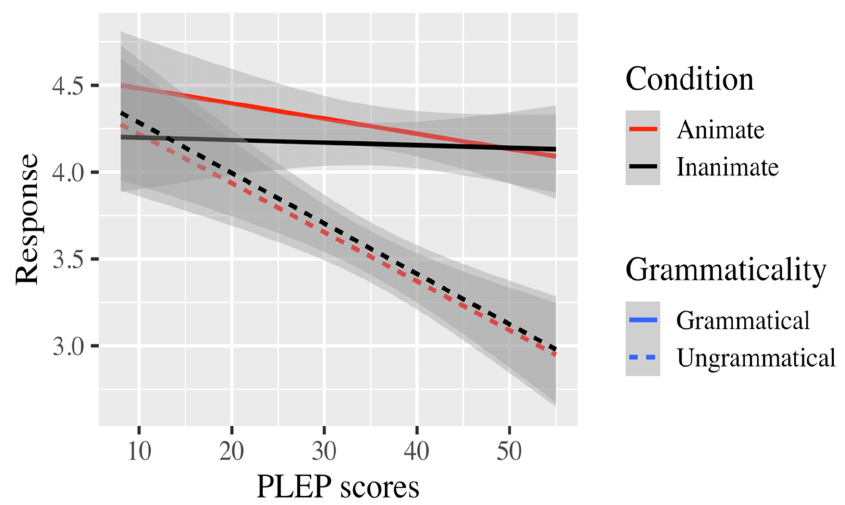
Figure 3. Acceptability of items (i.e., response) according to animacy (red vs. black lines), grammat- icality (solid vs. dashed lines), and PLEP scores in the Spanish AJT.